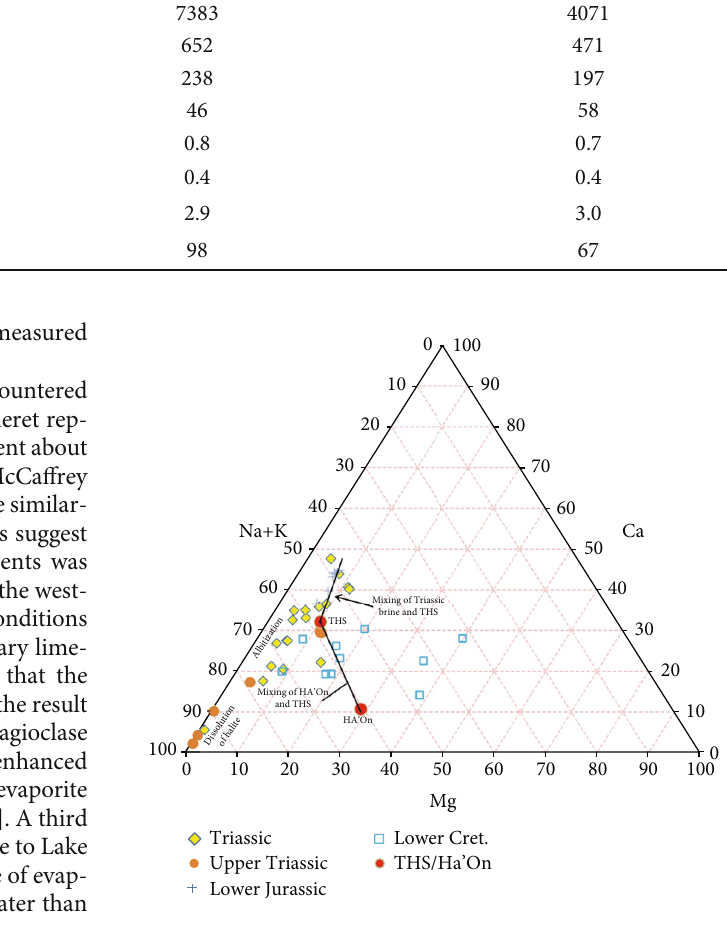
Figure 7: Triplot of brines (data in Table 1) indicating the dissolution of halite and dolomite, alteration of Ha ’ On brine into THS, and mixing of Triassic brine and THS. Except for the Tertiary Ha ’ On-THS brines, all the others are grouped according to their beds of occurrence. Percentages are based on